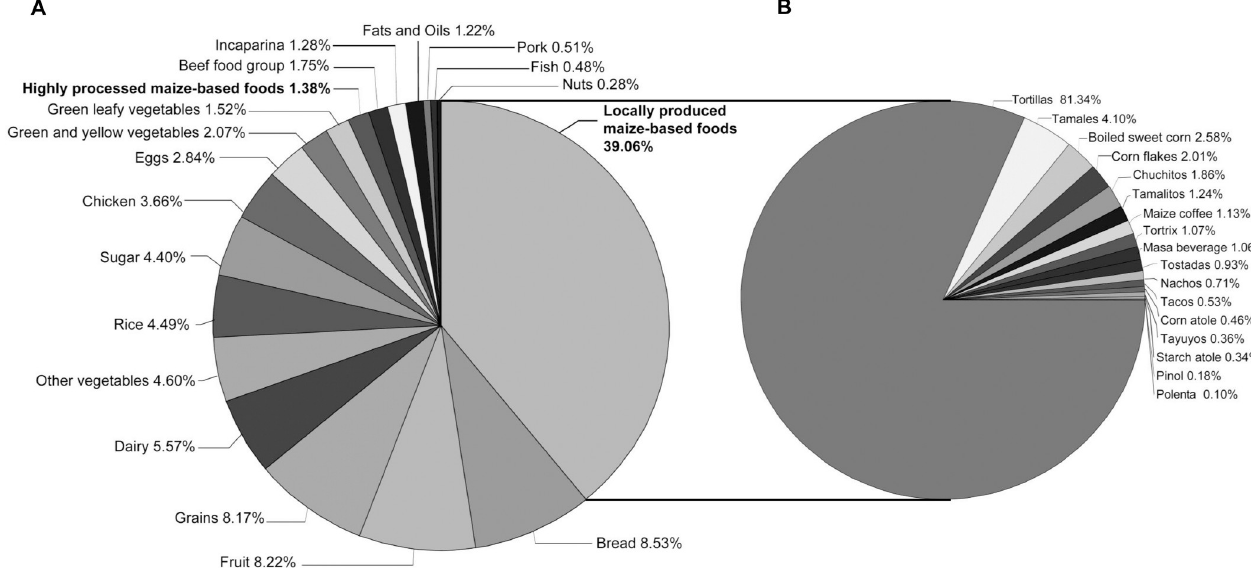
Fig 1. A Distribution of food groups, and B , highly processed and locally produced maize-based foods consumed in the week prior to study